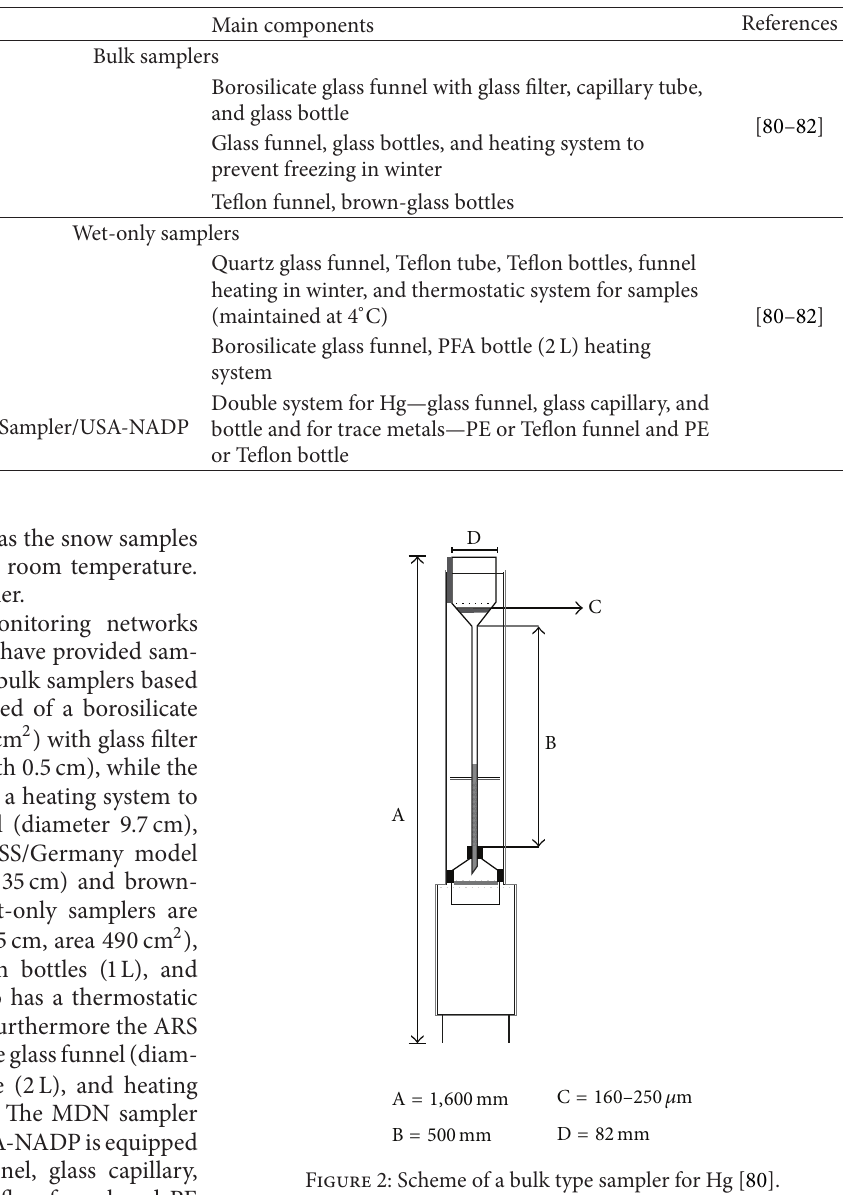
Table 4: Collectors used in atmospheric depositions of mercury.